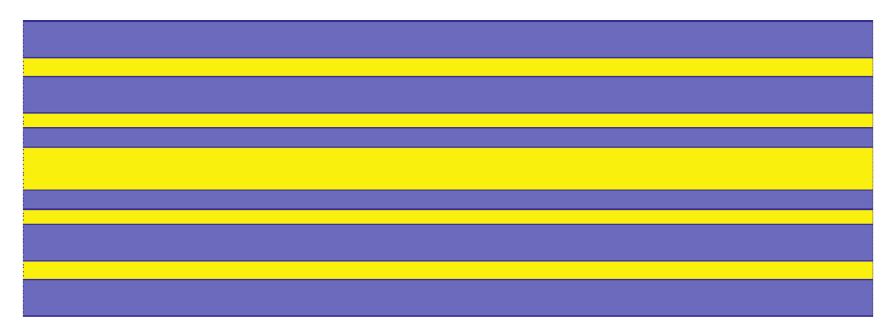
Figure 15: Target layer with a thickness of 80m.